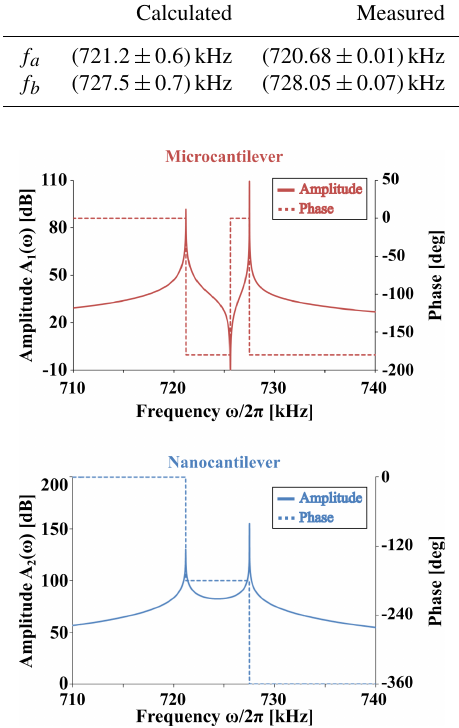
Figure 6. Bode plots for both subsystems of Fig. 4 without damping and external interaction obtained with the circuit analysis software LTspice.